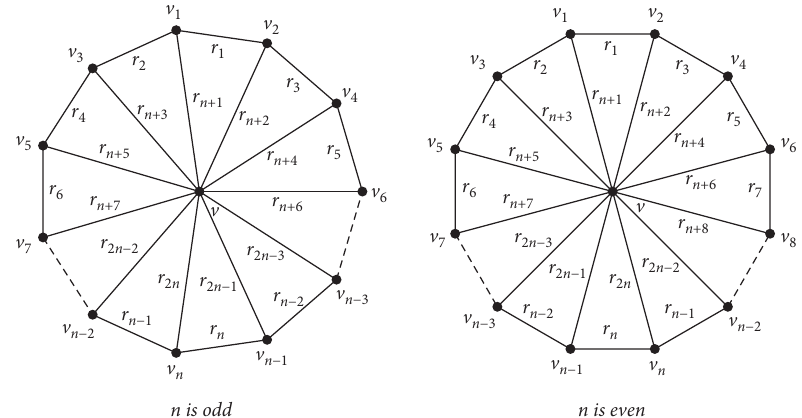
Figure 1: Edge labeling of W